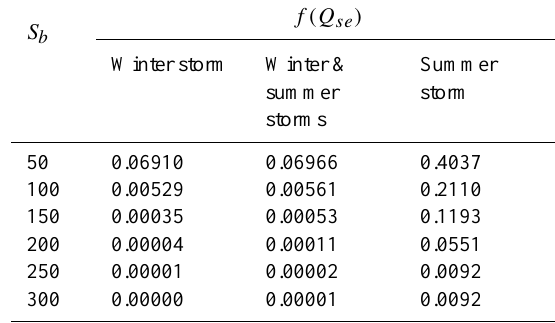
Table 3a. The frequency of occurrence for surface runoff.